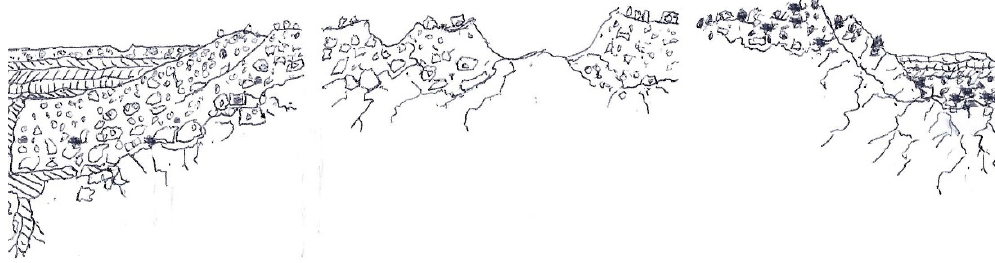
Figure 17. Schematic diagram showing aspects of lunar megaregolith evolution, existing on today’s Moon. Black indicates impact melts; white objects indicate primordial crustal fragments. Hatched materials are intrusive mare basalts. Note that boulder-sized rock samples, once ejected onto the surface, last for no more than a few hundred Ma (see text). At left is a 4.3 Ga-old basin, where intense early bombardment has rounded the rim profile and, within 100 Ma or so after basin formation, quickly “eaten through” the impact melts lens near the original floor of the basin, after which the basin floor was covered by intrusive and extrusive basalts. Few impact melt specimens can be found from this basin. Middle panel shows upland, where thick regolith has formed. A large young crater has penetrated the megaregolith and ejected onto the surface samples of crustal rocks (but few impact melts except as micro-clasts in the upland breccias). At the right is the Imbrium basin, ~3.9 Ga old. The impact rates were sufficiently lower after 3.9 Ga ago that only a thin megaregolith was created on the floor of the basin, and some impact melts survive there. Impact melts scattered from this region during the Imbrium-forming impact and by more recent moderate-sized impacts have maintained 3.9 Ga-old Imbrium impact melt presence (as well as primordial crustal rock samples) on the lunar surface in much of the region sampled by Apollo and Luna landings.